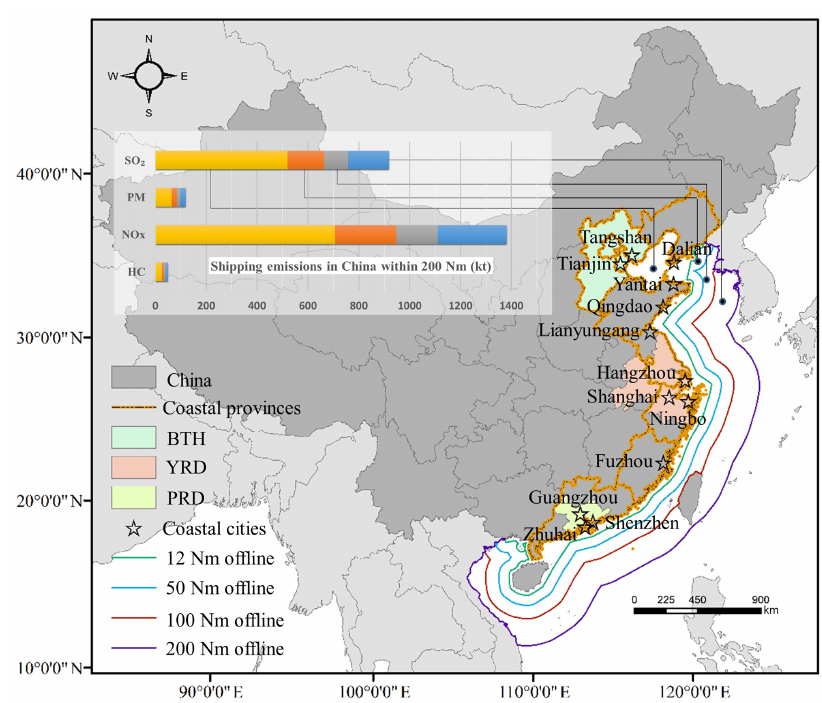
Figure 1. Study area and the contributions of different maritime areas for the total shipping emissions. The yellow, red, gray and blue columns represent the amount of shipping emissions in the areas within 12, 12–50, 50–100 and 100–200Nm of the Chinese coastline,